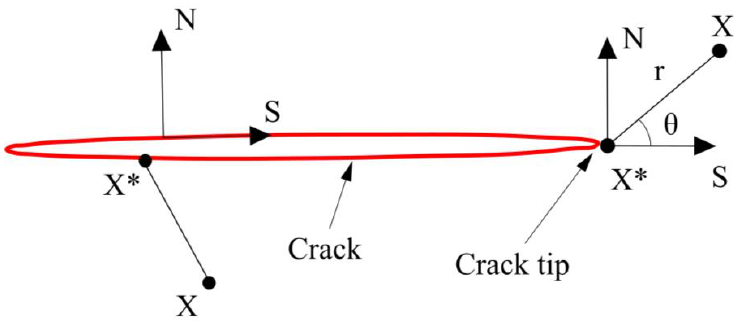
Figure 10. Local coordinate system of the crack tip.